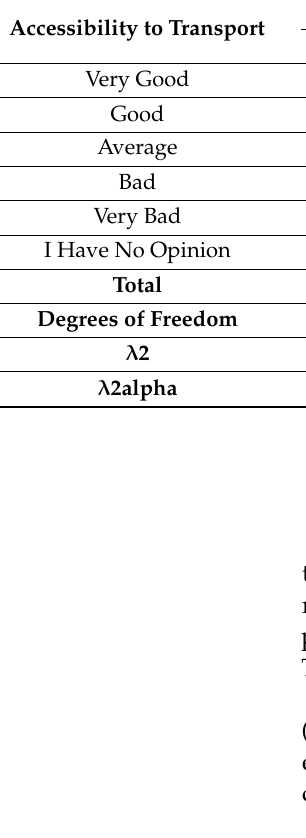
Table 6. Place of residence and assessment of the natural